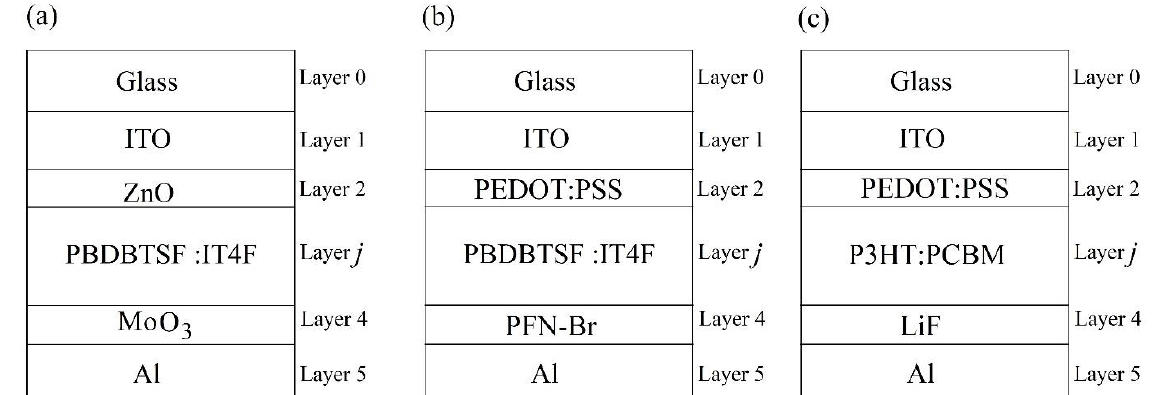
Figure 2. Three BHJ OSC structures considered in the simulation: ( a ) OSC1—an inverted BHJ OSC with non-fullerene acceptor, ( b ) OSC2—a conventional BHJ OSC with non-fullerene acceptor, and ( c ) OSC3—a conventional BHJ OSC with fullerene acceptor. Layer 1 is the front electrode (FE), layer 2 is the front charge transport layer (FCTL), layer j is the active layer, layer 4 is the rear charge transport layer (RCTL), and layer 5 is the rear electrode (RE).